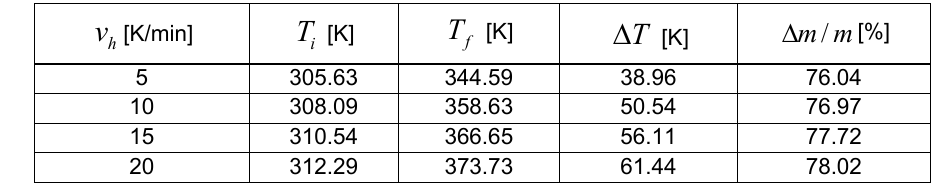
reaction intervals and percentage of residual masses for